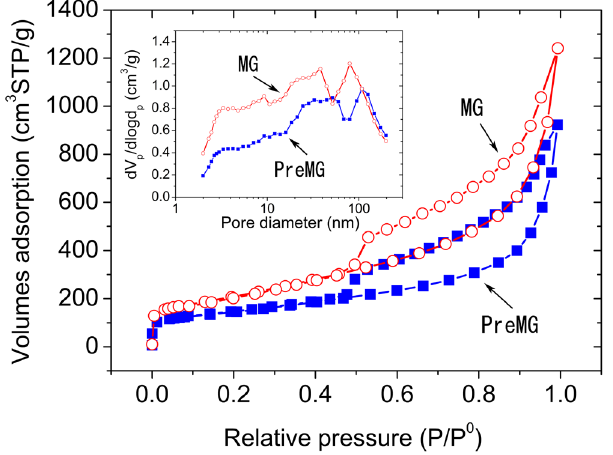
Figure 4. Nitrogen absorption isotherm of PreMG and MG. The inset graph is the pore size distribution of PreMG and MG.